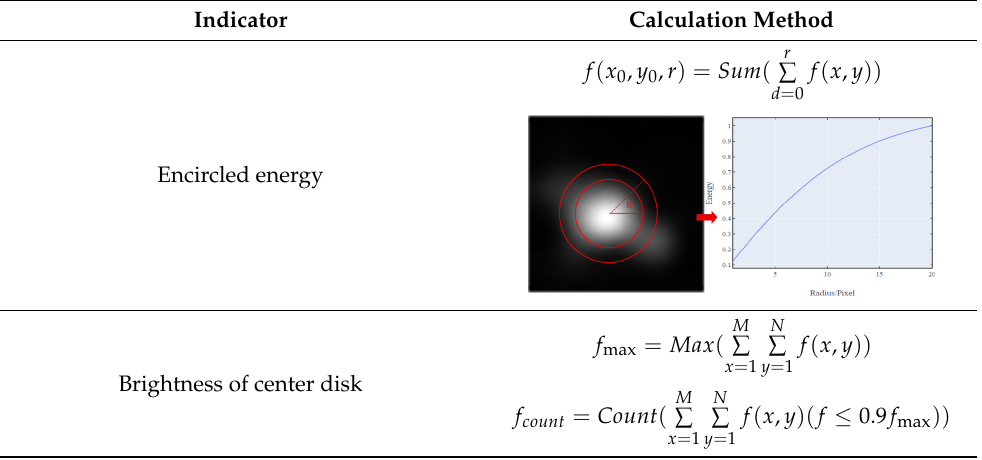
Table 2. Multi-index evaluation of the laser-emitting state.